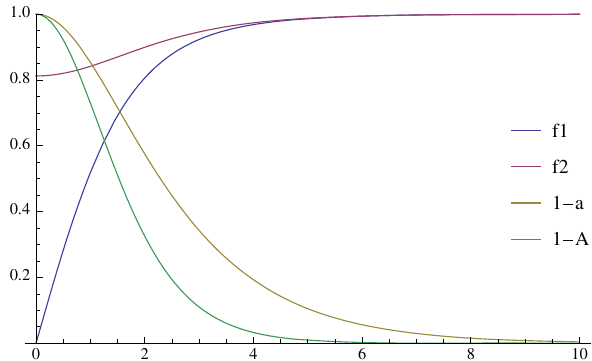
Fig. 1 The numerical solutions of the profile functions f 1 ( r ) , f 2 ( r ) , 1 − a ( r ) and1 − A ( r ) aredisplayedforavortexconfigurationofwinding number one as a function of r (the distance from the vortex center) for = 0 . 5 [1] l = e g